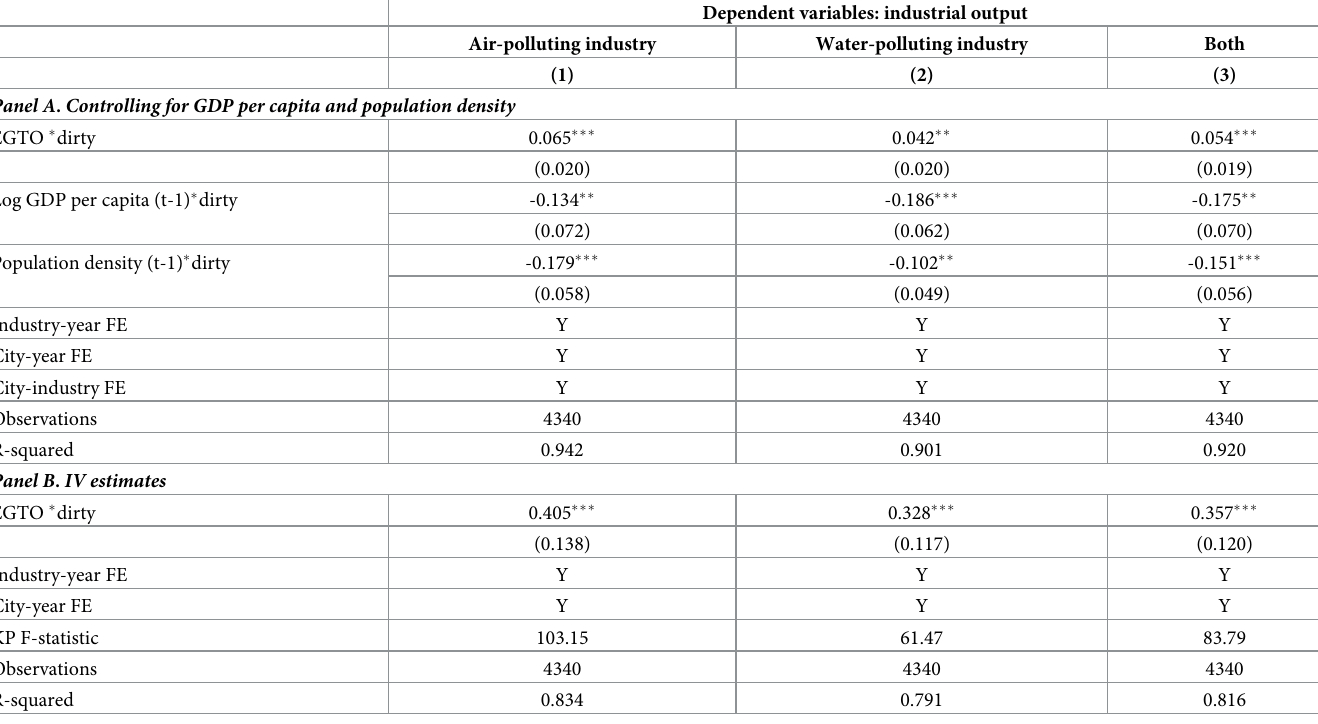
Table 4. Baseline results after addressing endogeneity